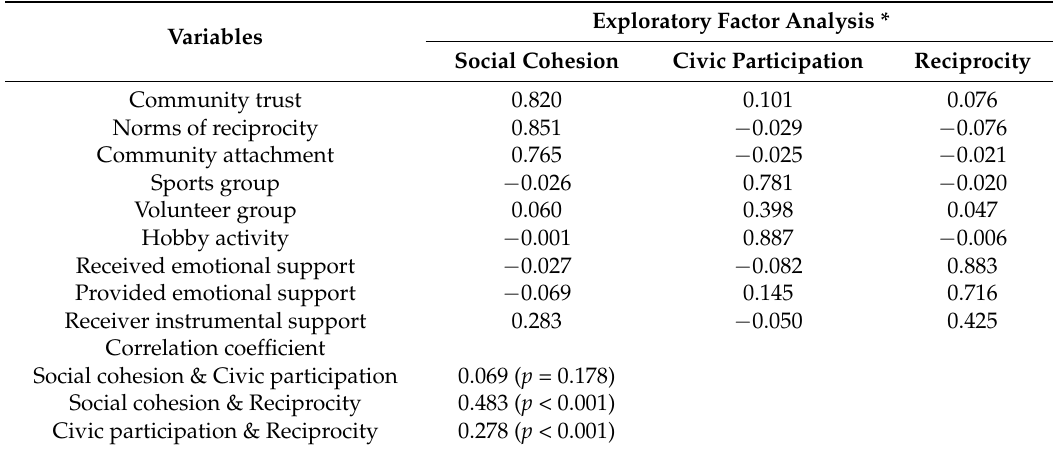
Table 2. Factor loadings of community-level social capital scale.